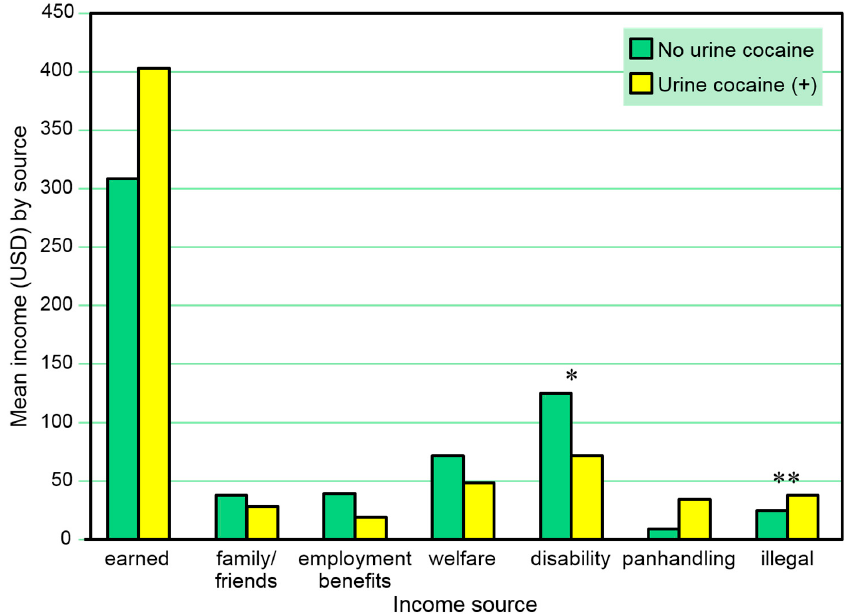
Figure 4. Amounts earned from various 30-day income sources among those with and without a positive urine cocaine test in the same month. * p ≤ 0.05, ** p ≤ 0.01.